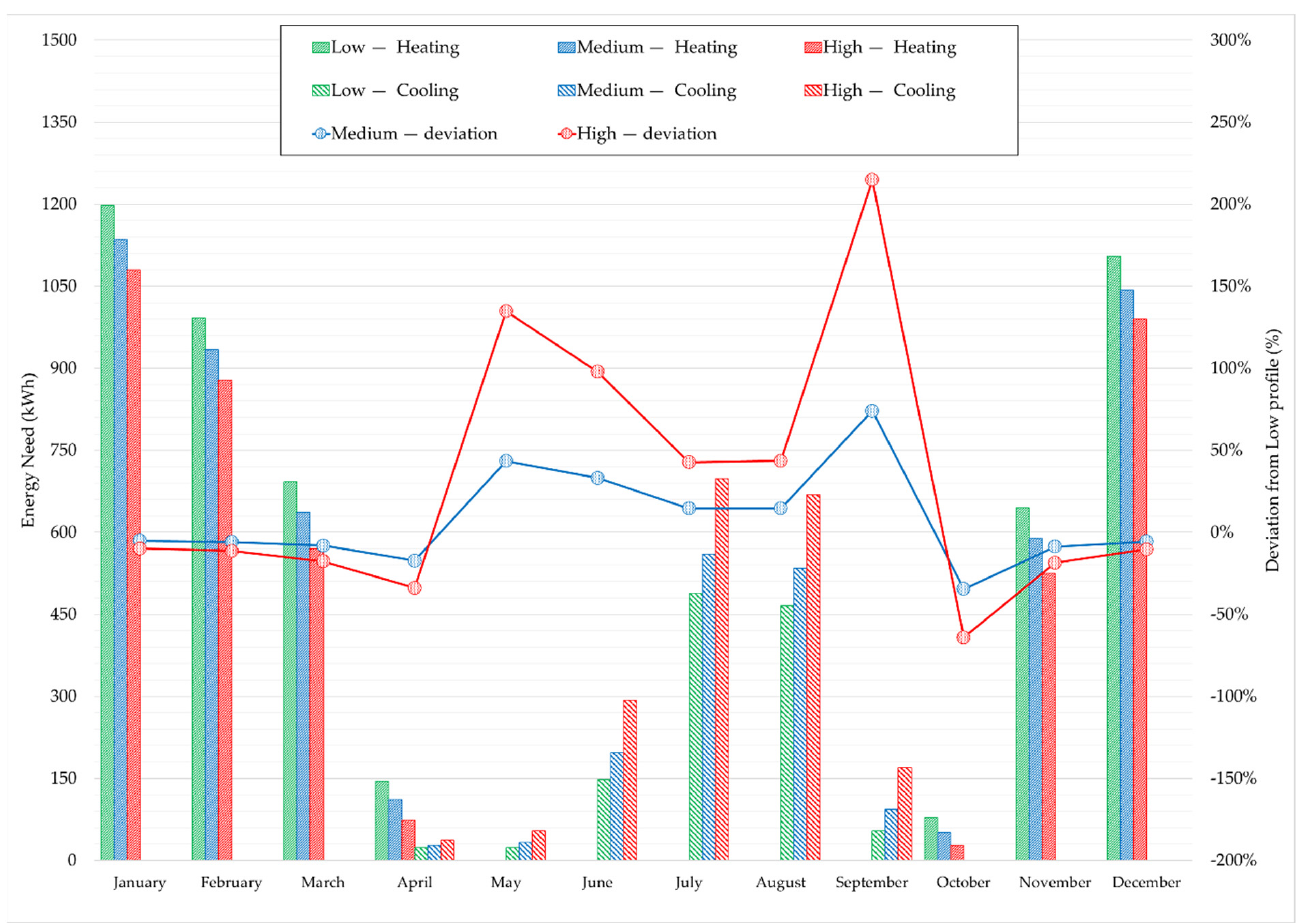
Figure 11. Energy needs for heating and for cooling in the three scenarios. A more accurate analysis of the energy needs as functions on the occupancy profiles is shown in Figure 12. In particular, the energy need for heating and for cooling were analysed with respect to indoor thermal loads (Q int ), where the low profile is indicated with the green series, medium with the blue ones, and high with the red series. Dots, referring to the same months, are joined through the same curve; they represent monthly values of energy needs for the heating and cooling periods for each case. As highlighted, the energy need for heating tends to decrease with the increase of Q int , the opposite can be observed for the cooling period.